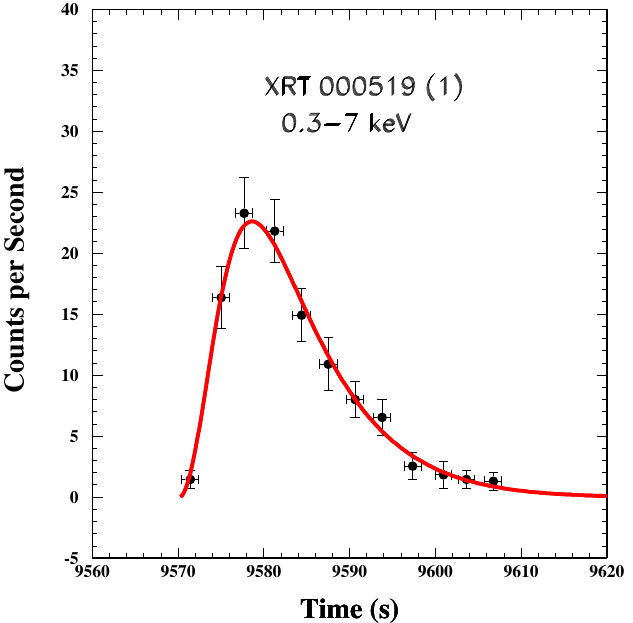
Figure 28. The best fit pulse shape given by Equation (24) for the first pulse of XRT 000519, reported in [77]. The fit parameters are ∆ = 9.65 s, τ = 17.50 s, E p ( 0 ) = 13.70 keV (for time t since 9570.10 s); χ 2 /dof =